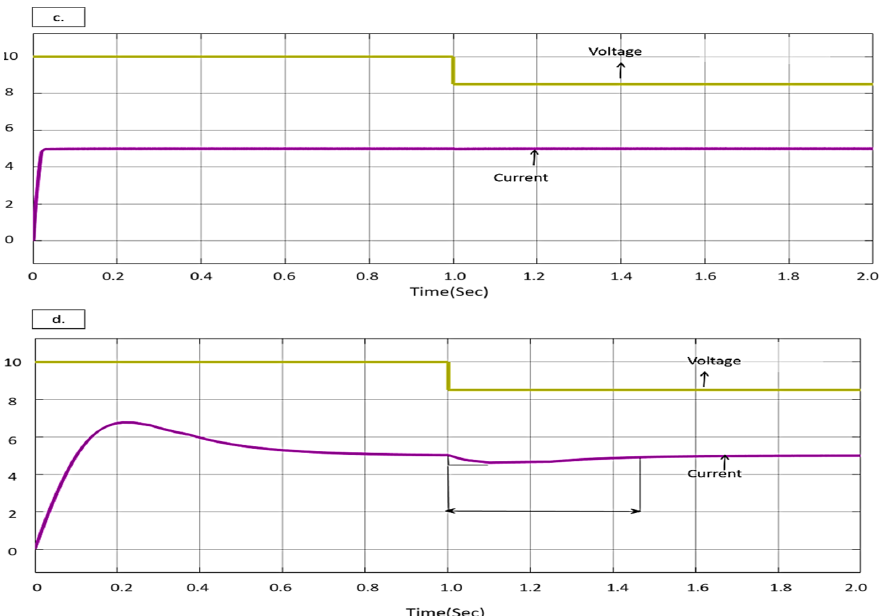
Figure 13. Simulation results during input voltage step-down (100 V to 85 V voltage scaling 1 box = 20 V): ( a ) FCC; ( b ) LCFF; ( c ) MBPS; ( d ) PI.